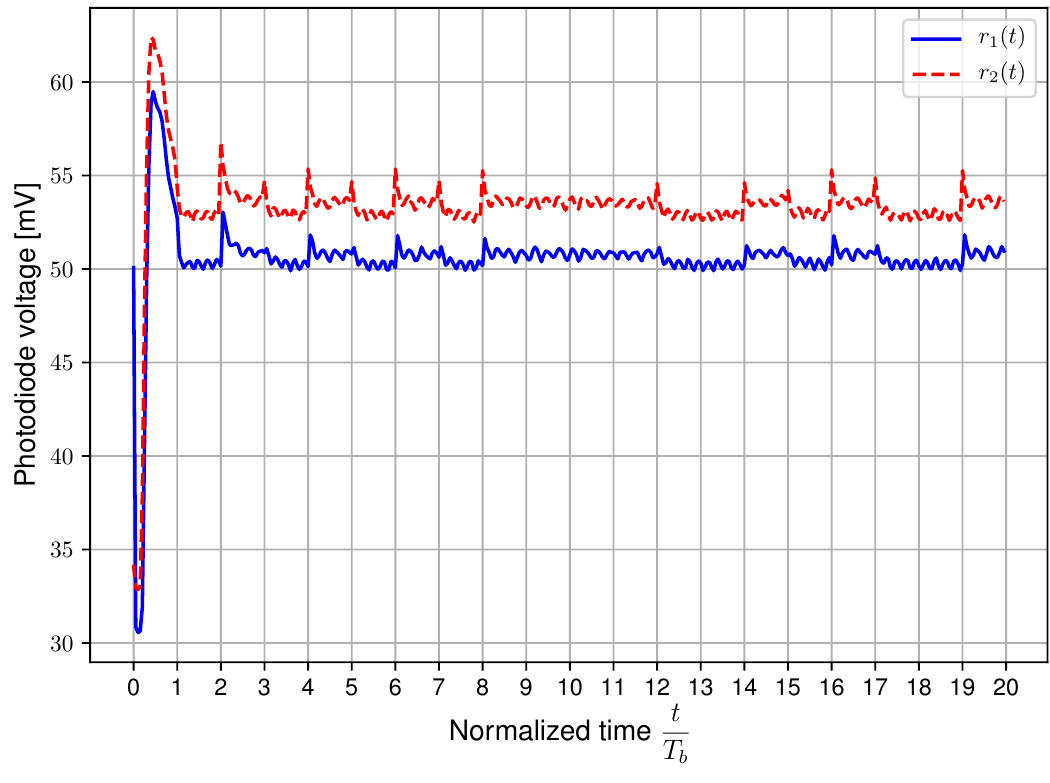
Figure 8. Measured photodiode voltages without receiver polarizers for bit period T b = 250 µ s using setup A